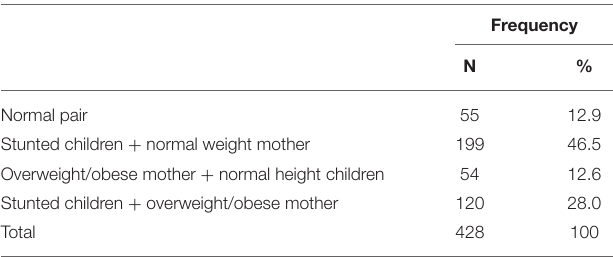
TABLE 3 | Coexistence of under- and over-nutrition in the same household, Surabaya,